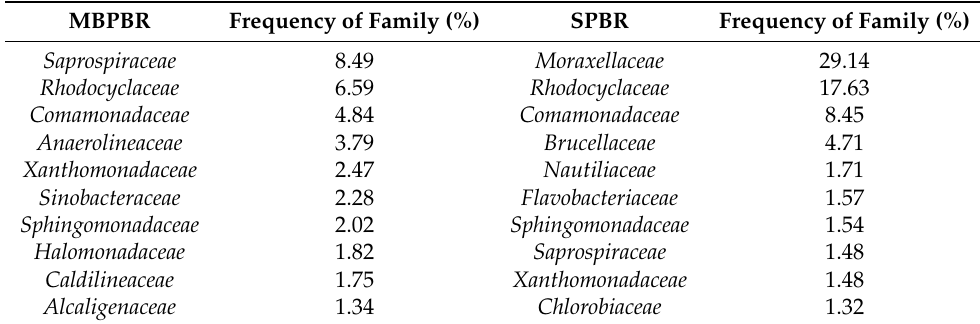
Table 2. Abundances of the top 10 families in each